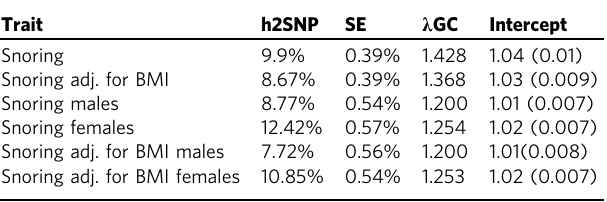
Table 3 SNP-based heritability of snoring on the liability scale.